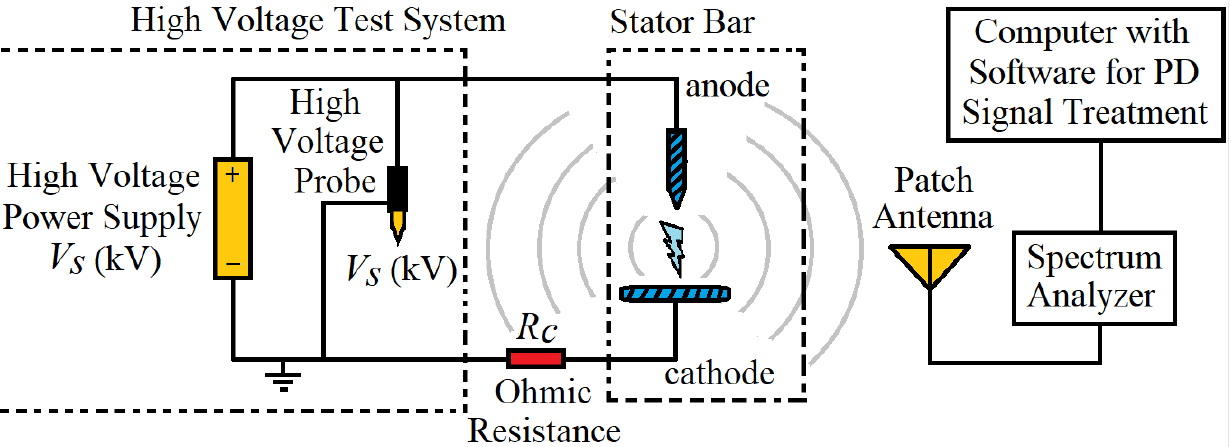
Figure 1. Representation of the discharge circuit proposed in [25]. The radiated electromagnetic field measurement setup (at right) is defined in this